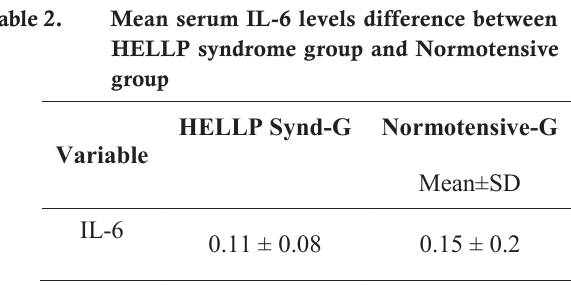
Table 1. Baseline comparisons for HELLP syndrome group to normotensive group. Variable